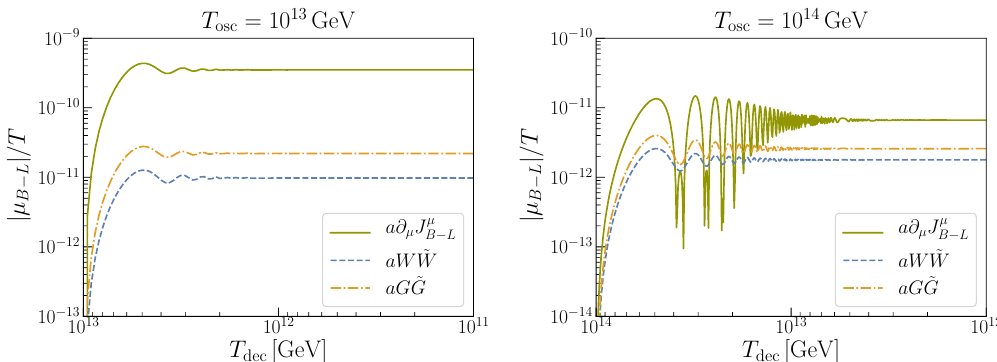
Figure 5 . The (cid:12)nal B L asymmetry produced for di(cid:11)erent values of the axion decay temperature (cid:0) T dec . The axion oscillation temperature is taken as T osc = 10 13 GeV in the left panel, and T osc = 10 14 GeV in the right